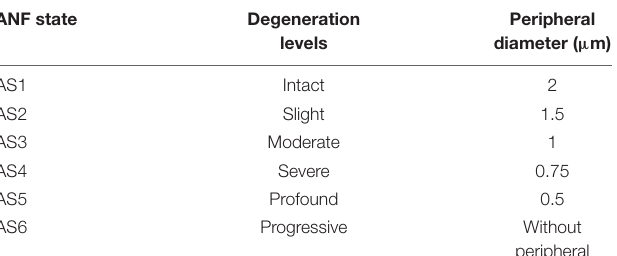
TABLE 2 | Six ANFs status based on degeneration levels of peripheral diameter.